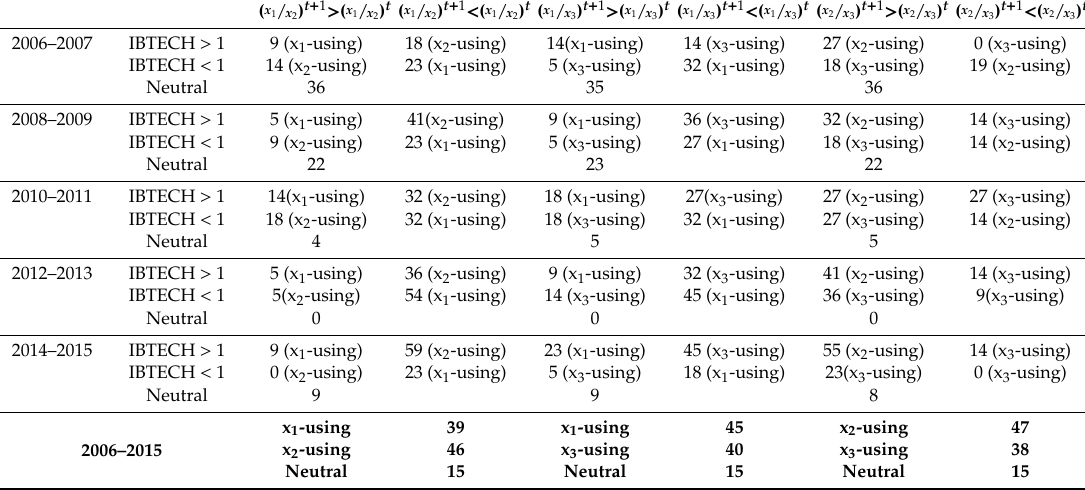
Table 6. Input-biased technical change (%) a .